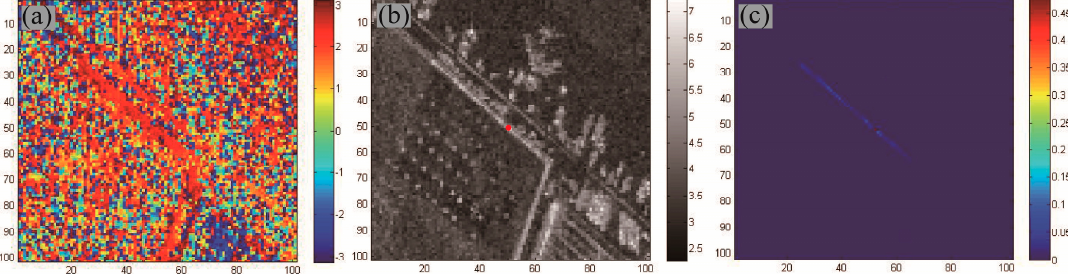
Figure 3. Searching window W S at each site.